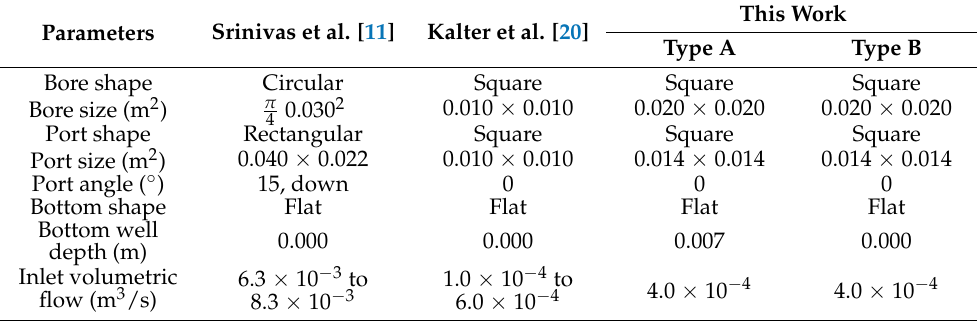
Table 1. Geometric characteristics and volumetric flow comparison between different nozzle scaled